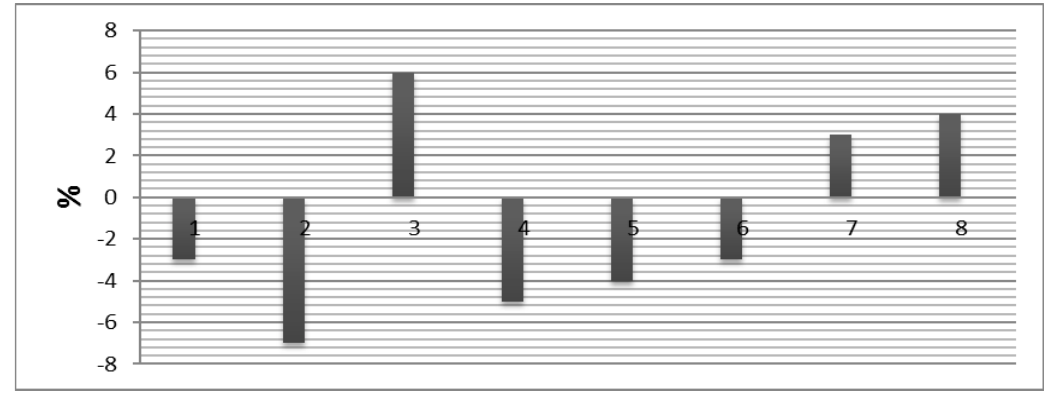
Fig. 7. Changes of bio-mechanical characteristics of elite cyclists in periods of fatigue’s overcoming and evident fa- tigue at trainings of aerobic